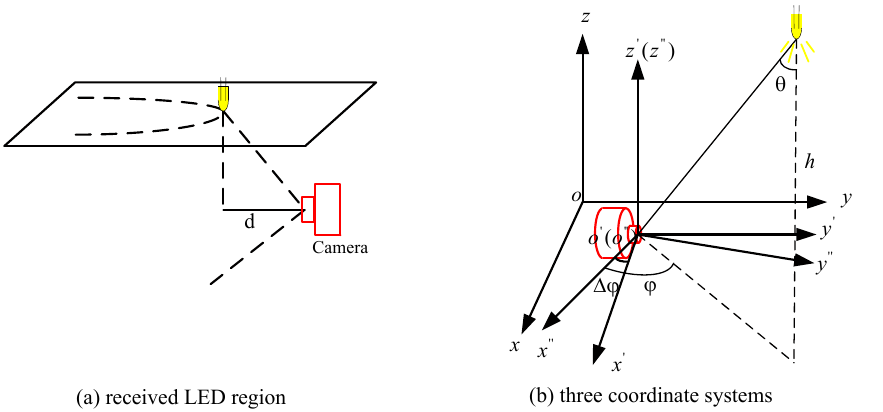
Figure 2. Schematic diagram of the vertical reception